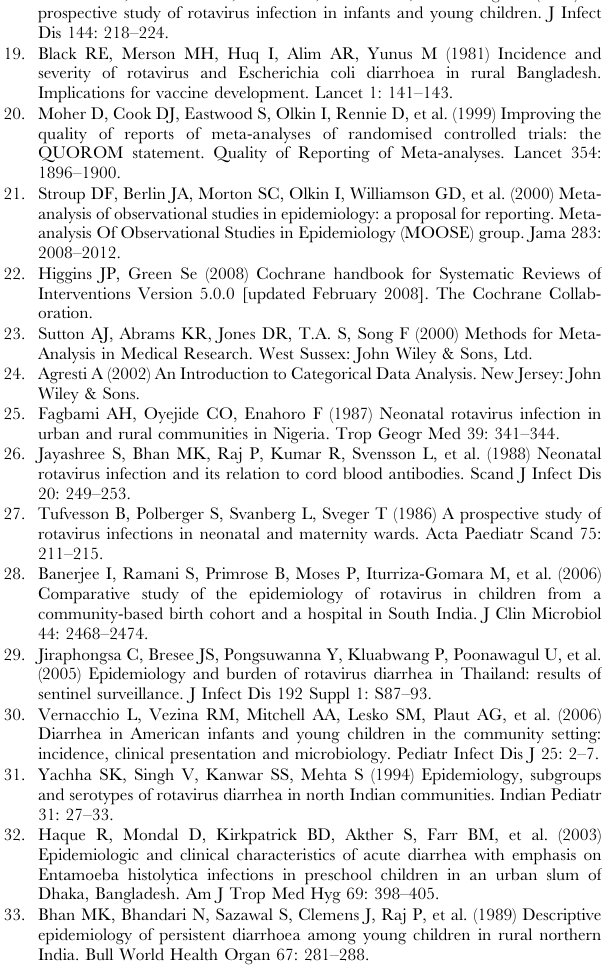
Table S2 Details on the way incidence of symptomatic RV infections in children , 2 years of age were obtained from studies included in the meta-analysis.